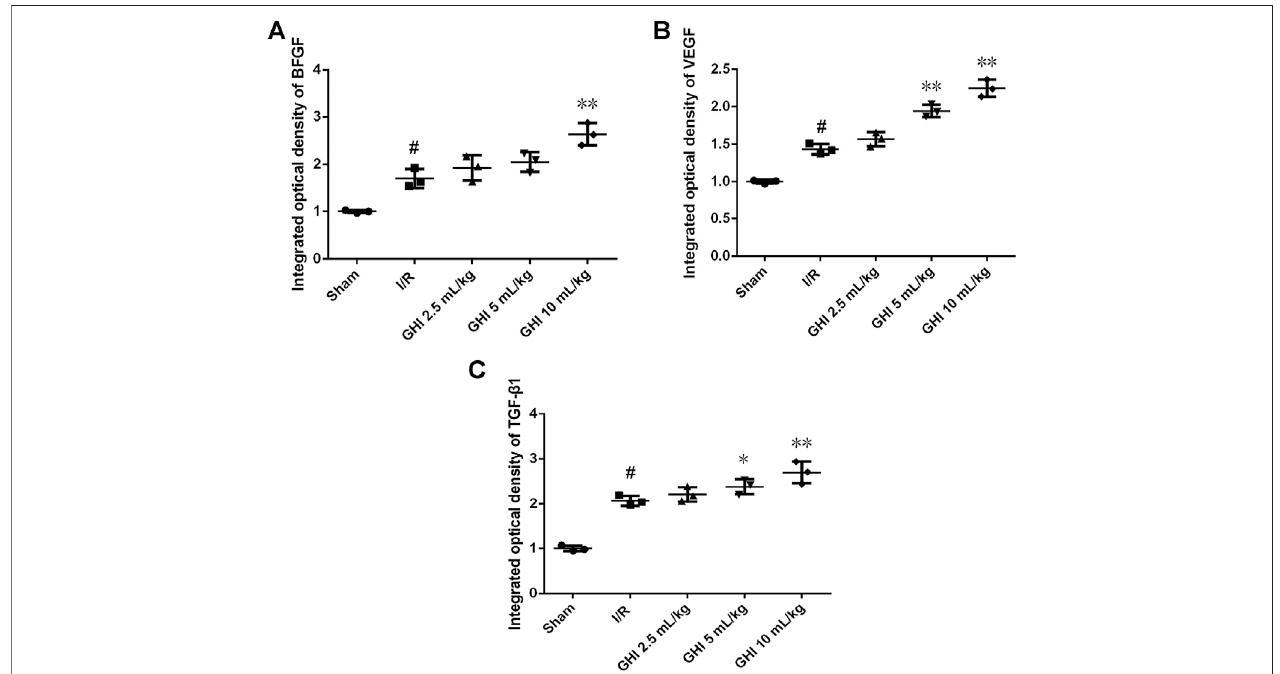
FIGURE 6 | Immunohistochemical analysis of BFGF, VEGF, and TGF- β 1 cerebral I/R hippocampal CA1 region. Groups were as follows: Sham group (Sham), ischemia-reperfusion group (I/R group), GHI 2.5 ml/kg group, GHI 5 ml/kg group, and GHI 10 ml/kg group. The data were expressed as means ± SD (n (cid:2) 3 rats per group). ## p < 0.01 vs. the Sham group, * p < 0.05, ** p < 0.01 vs. the I/R group.